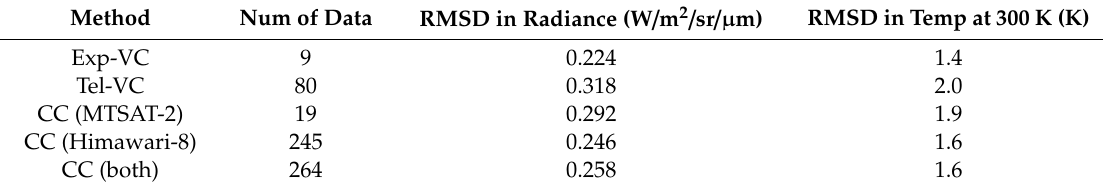
Figure 17. Difference between the recalibrated radiance ( R x ) and the predicted radiance for ALOS-2 / CIRC as a function of the day since the launch ( D ). Table 3. Number of data used, RMS di ff erence in radiance, and that in temperature at 300 K for the ALOS-2 / CIRC recalibrated radiance in each of Exp-VC, Tel-VC, and CC (MTSAT-2, Himawari-8, and both).